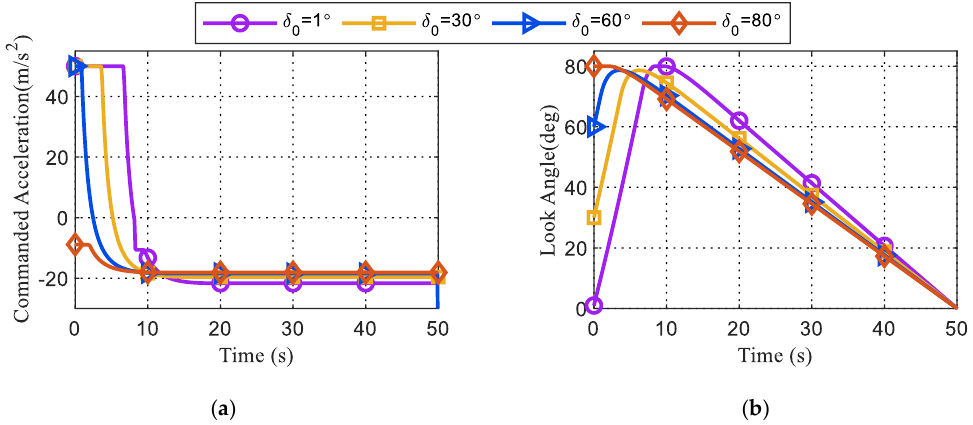
 = 80°. ( a ) Lateral accelerations; ( b )